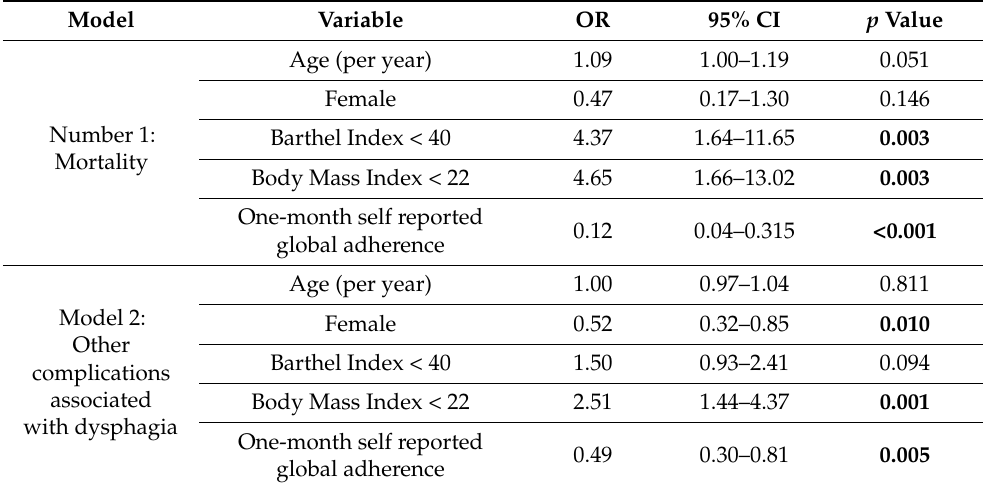
Table 4. Multivariate Cox Analysis: Variables associated with death and other complications associ- ated with dysphagia one month after